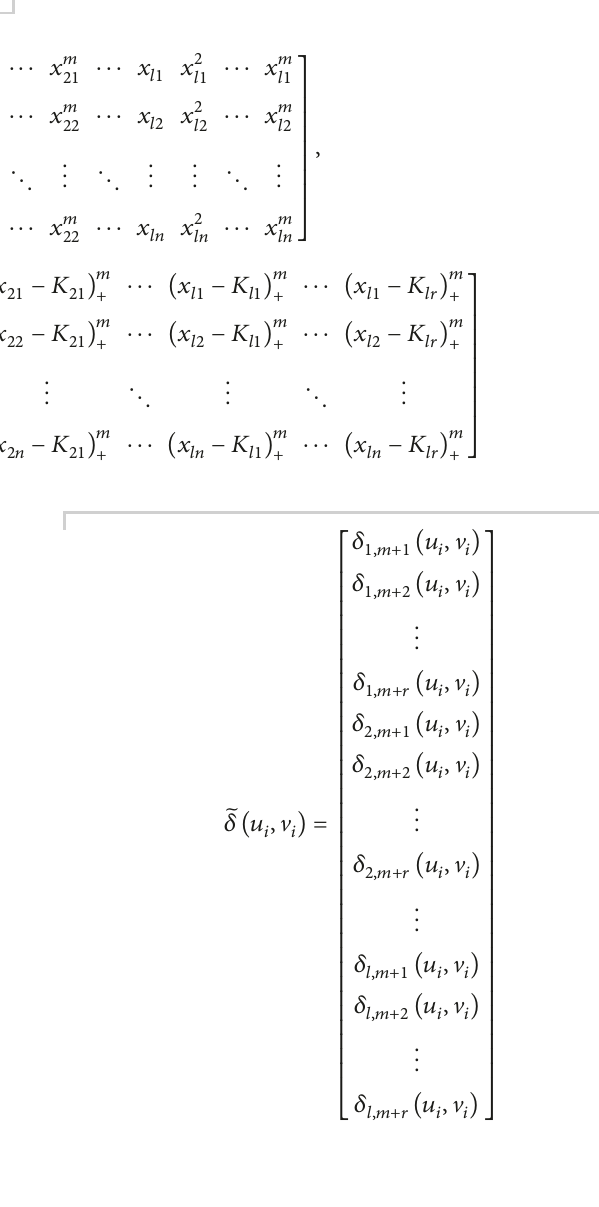
Matrix X is sized 𝑛 × (1 + 𝑙𝑚) ; matrix P contains predictor variable of truncated function sized 𝑛 × 𝑙𝑟 . Vector is a parameter vector sized (1 + 𝑙𝑚) × 1 . Vector parameter vector containing truncated function sized 𝑙𝑟 × 1